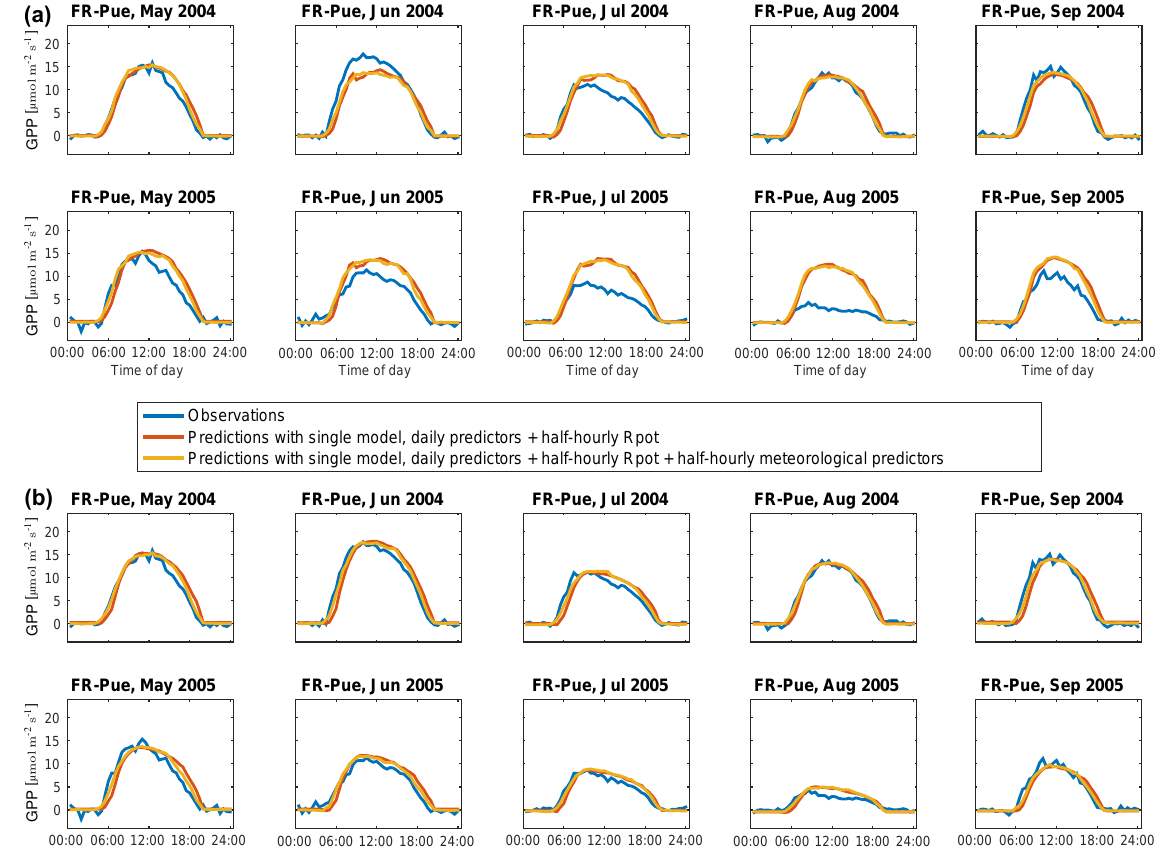
Figure 11. Improvements in the initial estimations (a) at FR-Pue can be observed when using daily GPP as an additional daily predictor if it would be available a priori (b) . Hence, the problems with seasonal drought effects would be greatly reduced in the leave-one-site-out setup for every half hour of the diurnal cycle in the case when an accurate estimate of the daily average value is